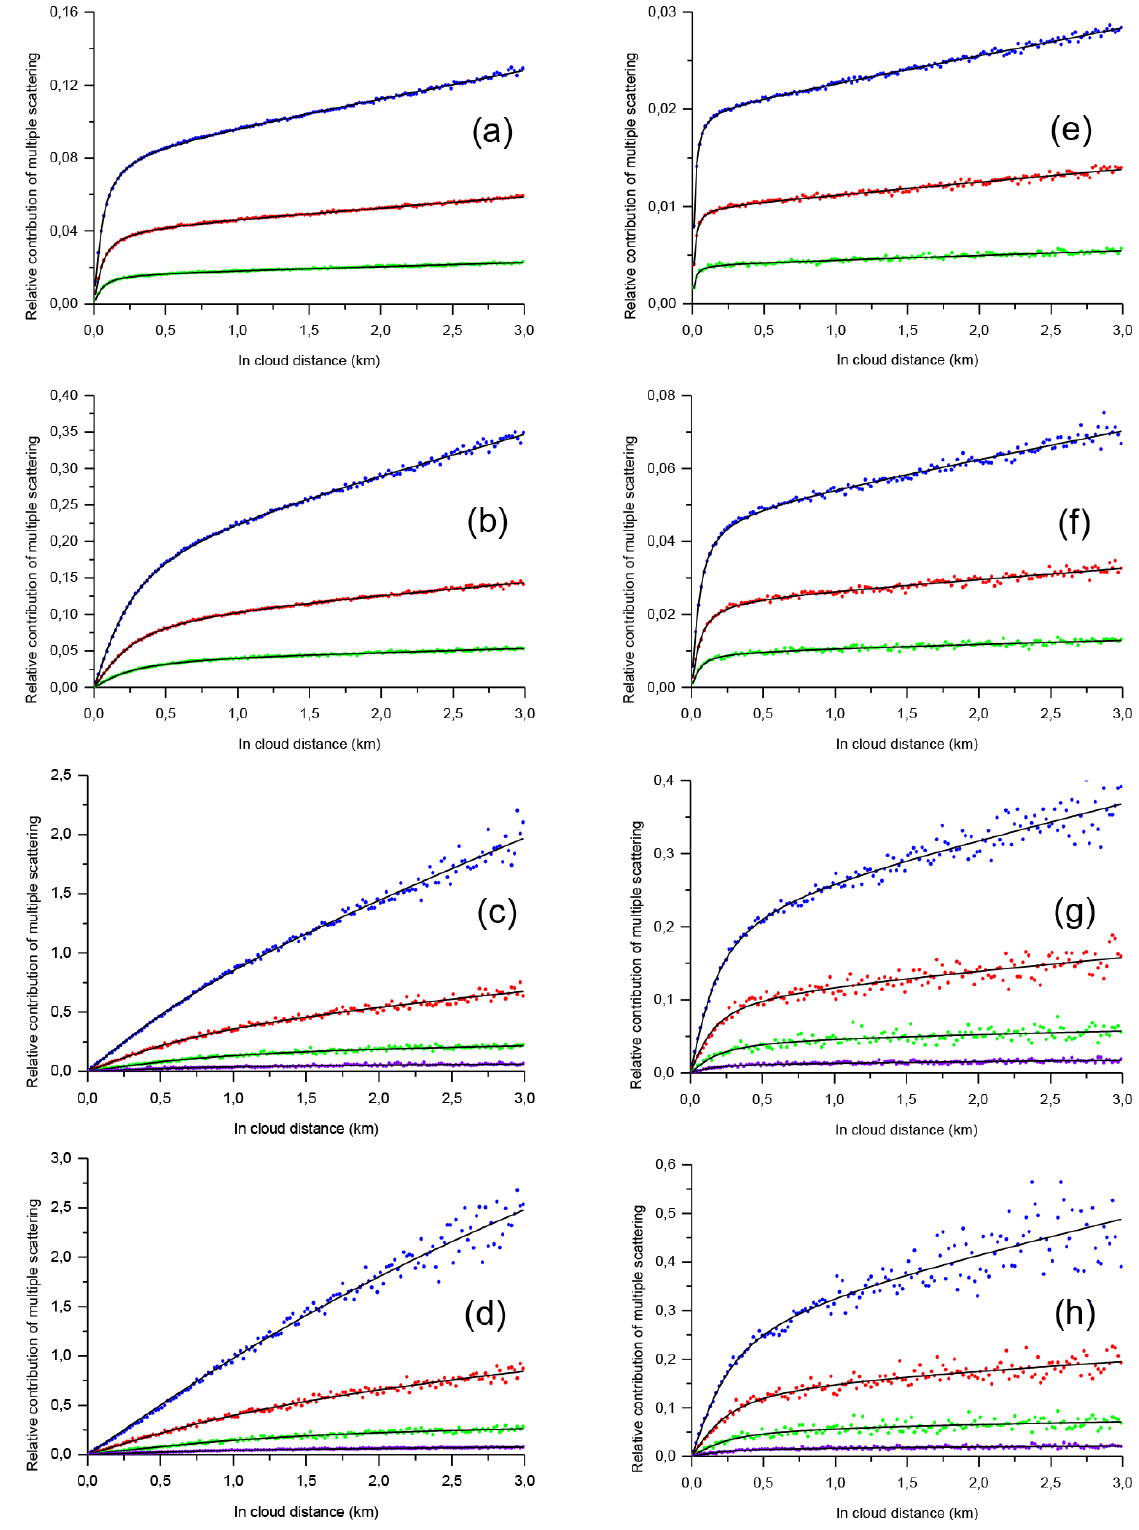
Figure 3. Multiple-scattering contributions R MSto1 to lidar signals. Points – MC simulations, black lines – fitting with the empirical model. The full RFOV is 1.0mrad (a–d) and 0.25mrad (e–h) . Coarse aerosol (a, e) , water cloud (b, f) , JS cirrus (c, g) , Ci cirrus (d, h) . The extinction coefficient is 1.0km − 1 (blue points), 0.5km − 1 (red points), 0.2km − 1 (green points), and 0.06km − 1 (purple points). The distance to the cloud base is